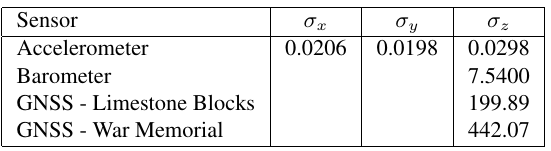
Table 2: Calibration offsets for sensors.